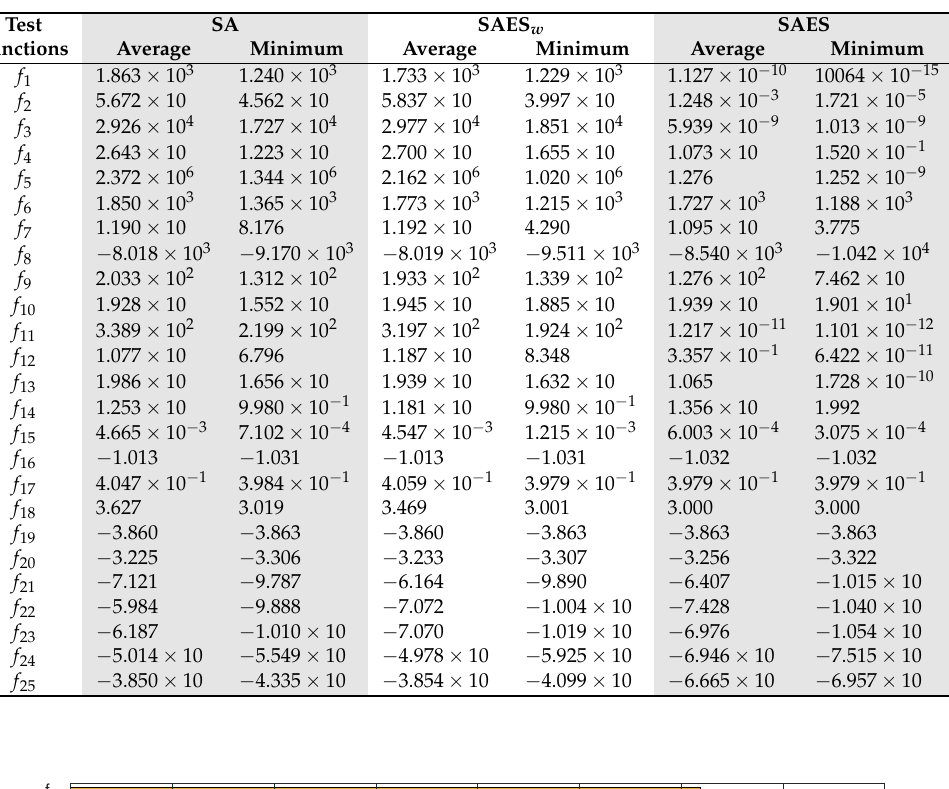
Table 2. Average and minimum objective function values obtained by the SA methods using the classical test functions.